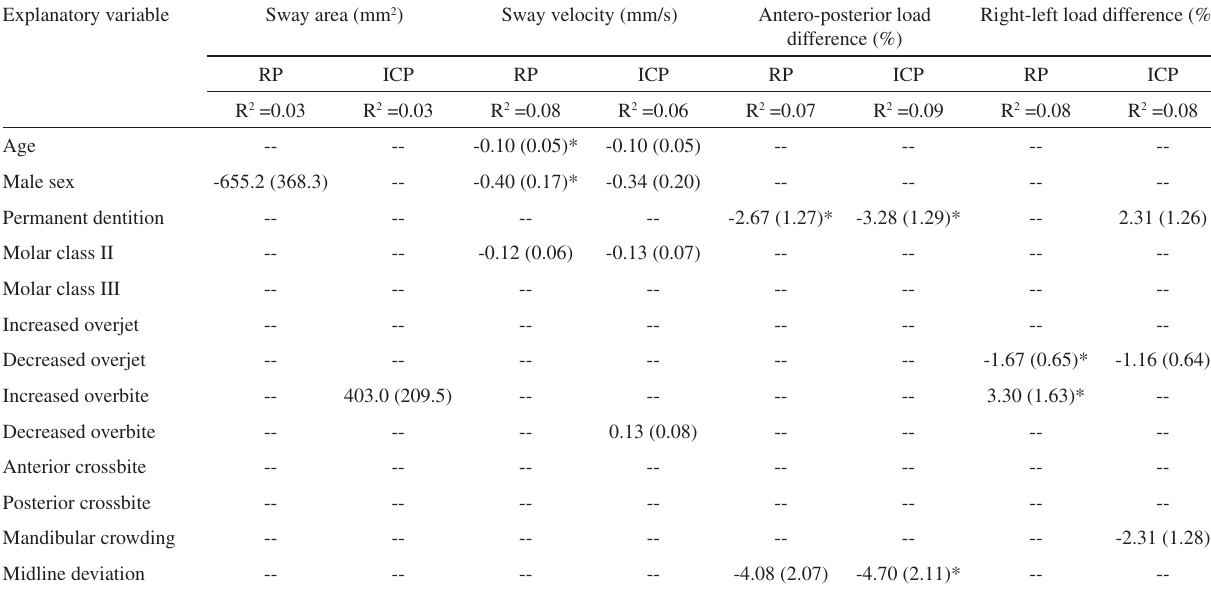
Table 3 - Results of the backward multiple linear regressions for estimating the correlations between the postural parameters and each explanatory variable in the rest and intercuspidal mandible positions (n =